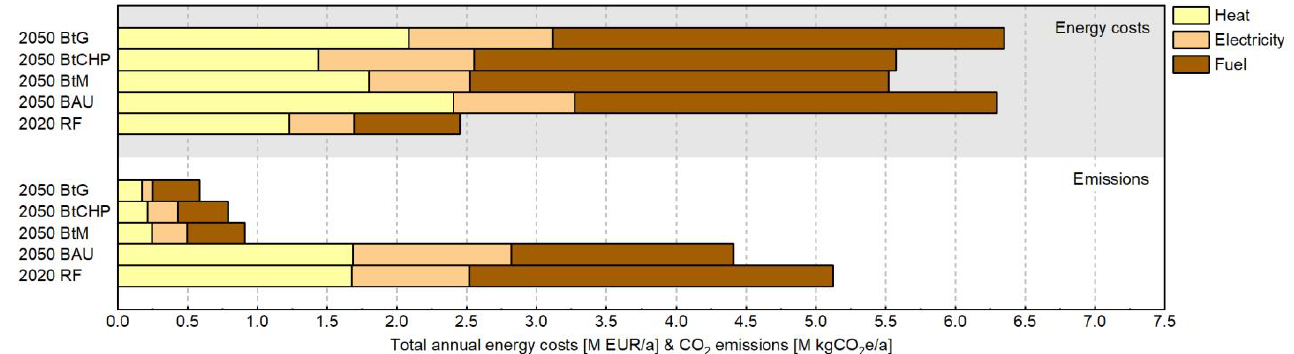
Figure 11. Comparison of total annual CO 2 e emissions and costs of the reference case (2020) with assumed scenarios (2050).